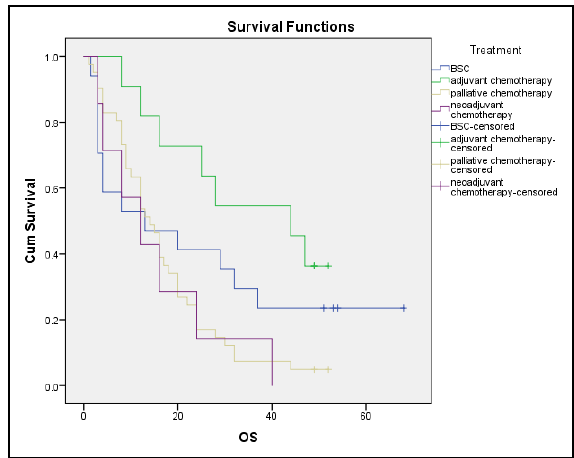
Figure 2: Relation between overall survival and treatment